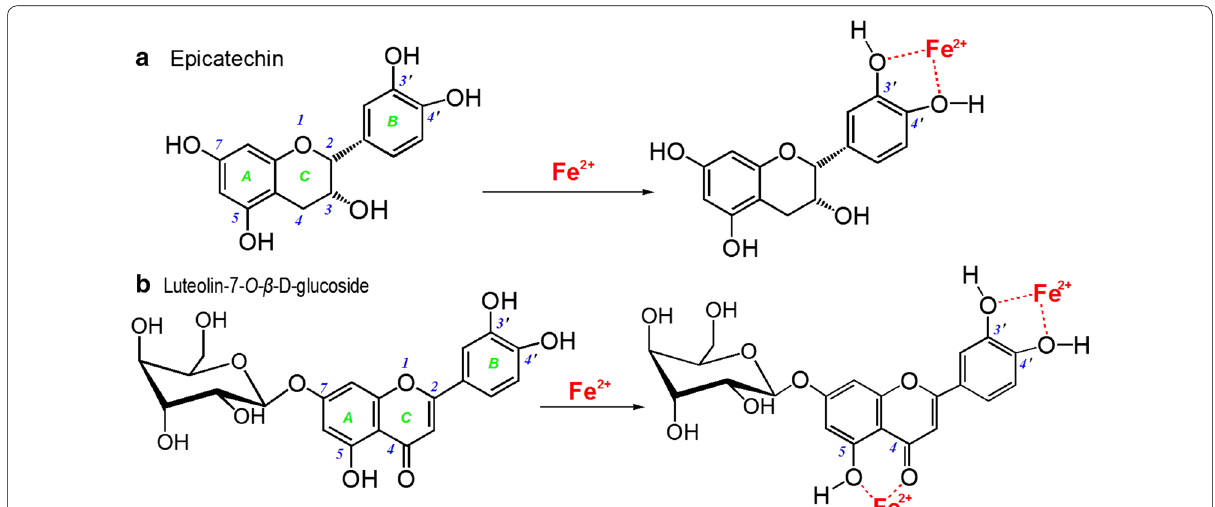
Fig. 6 The proposed Fe 2 + -binding reactions with a catechol moiety in epicatechin ( a ) and with catechol and hydroxyl-keto moieties in luteolin-7- O - β -D-glucoside ( b